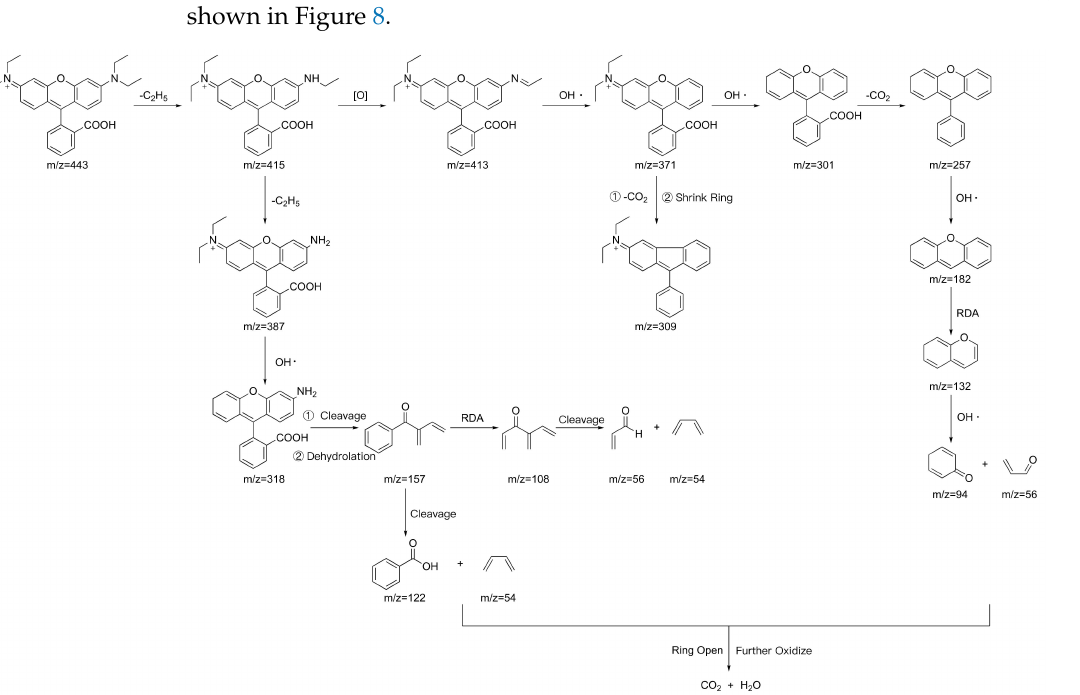
Figure 8. Proposed decomposition pathways of RhB in the ACAP/Fenton treatment